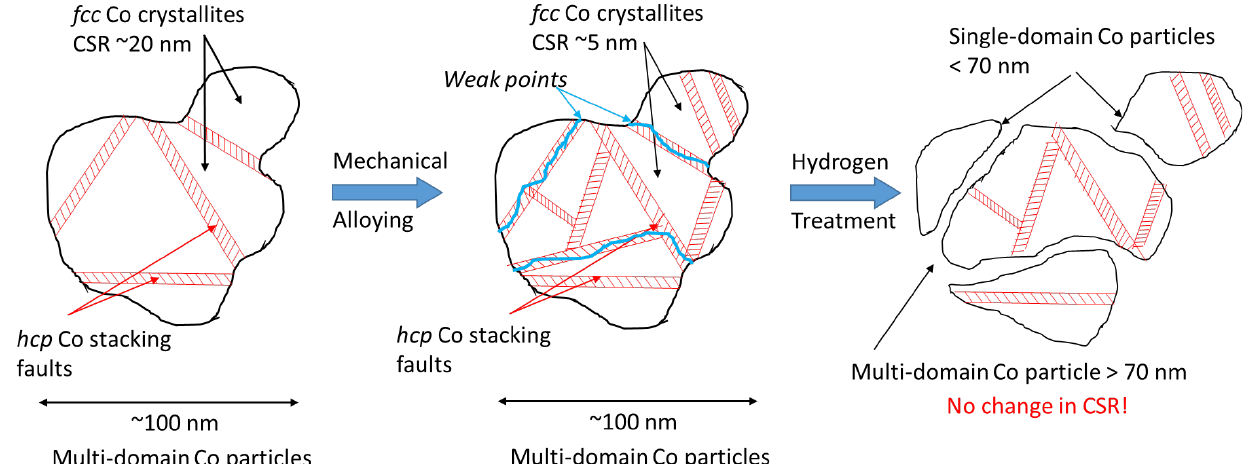
Figure 11. Possible scheme describing the effect of mechanical alloying and hydrogen treatment on the metallic Co particles. Mechanical alloying introduces high amounts of stacking faults and weak points into the initially well-ordered particles, decreasing the average size of the coherent scattering regions (CSR). The subsequent hydrogen treatment breaks the particles at weak points, forming magnetically single-domain particles without changing the CSR.